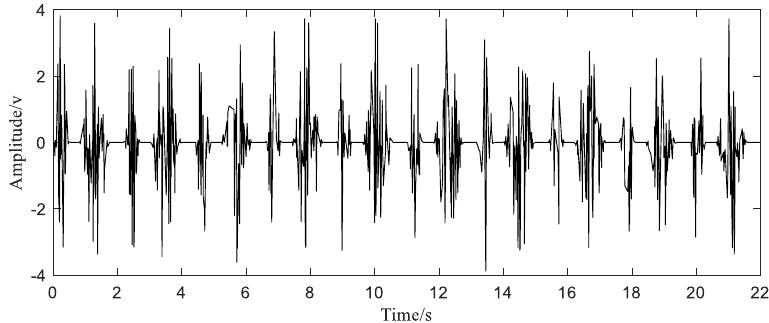
Figure 4. The initial signal with sub-Nyquist sampling rate.